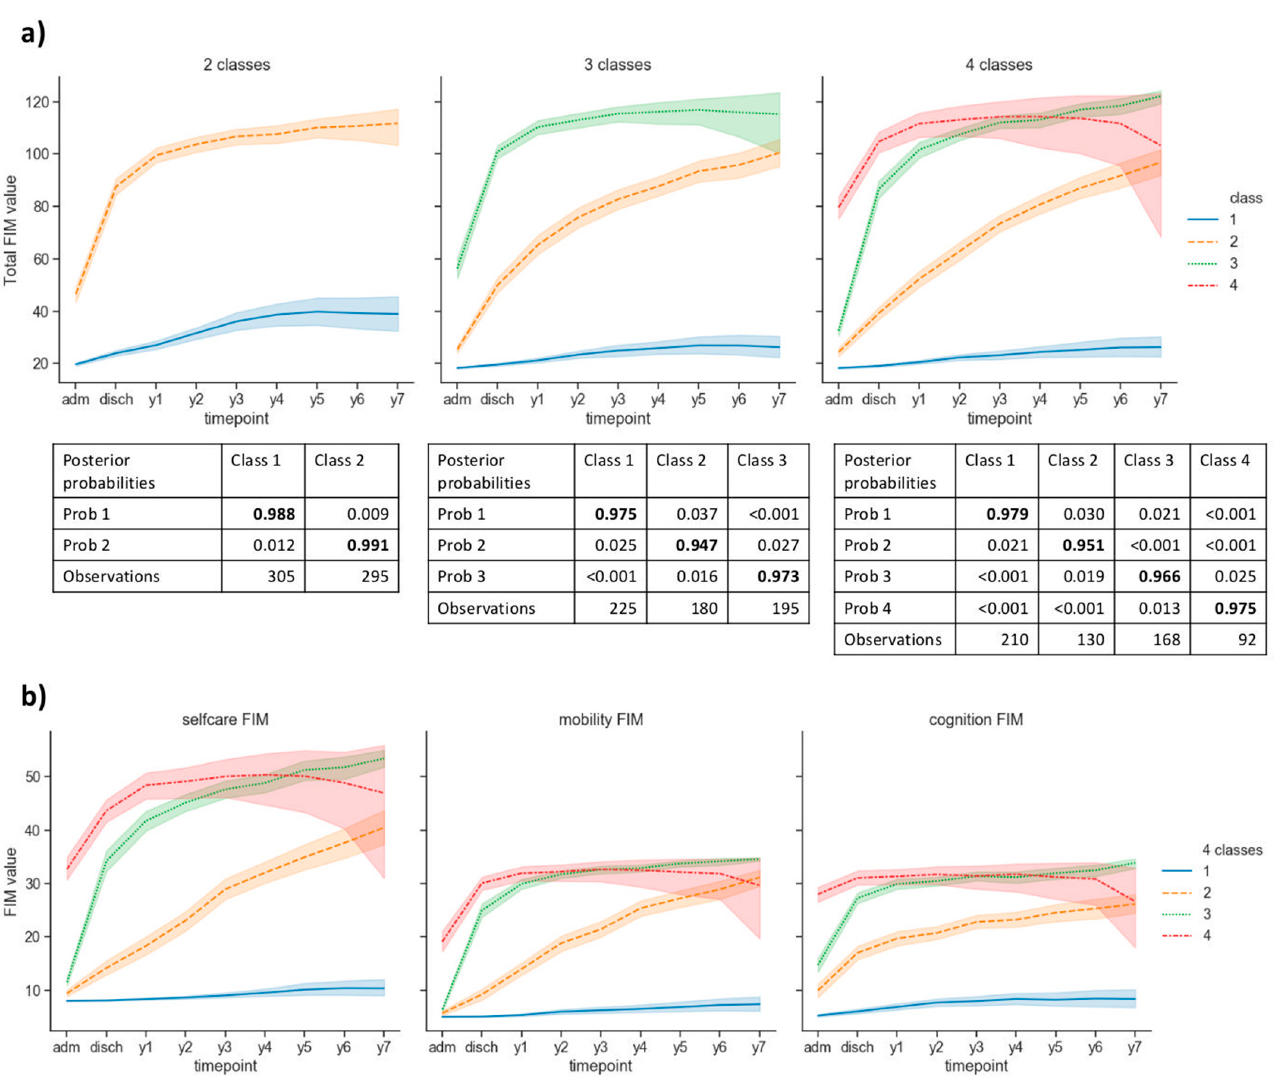
Figure 1. ( a ) Typological analysis. From left to right: two, three and four classes clustering. Two-classes clustering separated what we called responders (orange) from non-responders (blue). Three classes clustering isolated fast- (green), slow- (orange) and non-responders (blue). Four classes clustering separated high-start fast (red), low-start fast (green), slow (orange) and non-responders (blue). “adm” and “disch” indicate first admission and discharge, respectively. Numbers in bold indicate the posterior probabilities for each trajectory to be assigned to the correct class. ( b ) From left to right, the same typological analysis identified four classes of trajectories in each FIM domain: selfcare, mobility and cognition.